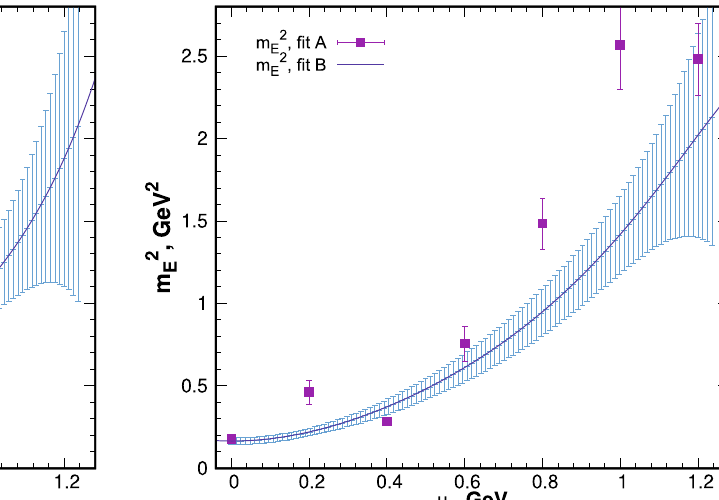
0 ≤ p < 2 GeV (right). Curves show interpolated values of the screen- ing masses evaluated by the formula (21), the respective corridors of errors are shown by error